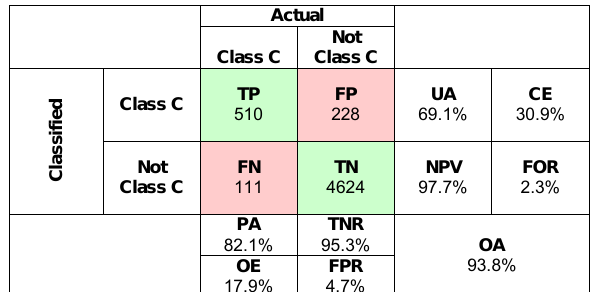
Table 1. Binary confusion matrix (Example data are taken from Campbell, 1996) where TP is the true positive (hit or power), TN the true negative (correct rejection), FP the false positive (false alarm, Type I error) and FN the false negative (miss, Type II error) values. Colours are representing the correctness of the